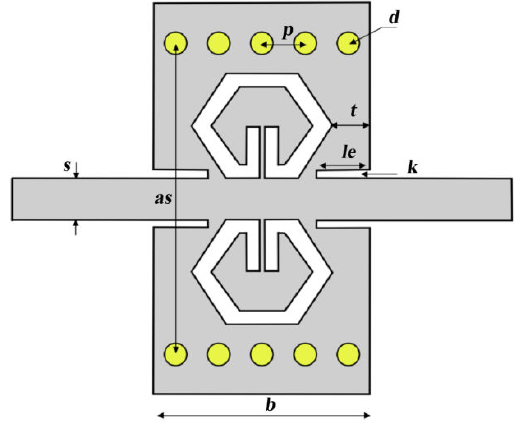
FIGURE 3. Layout of the tunable SIW filter with a two C-HMC. TABLE I. Dimensions of the SIW proposed tunable filter with two C-HMCs (unit: mm). Parameters